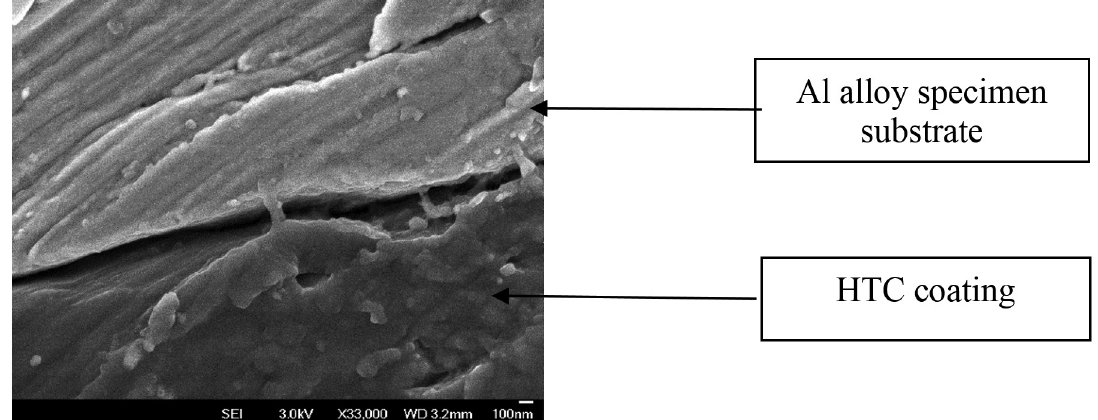
Figure 4. Scanning electron micrograph of cross section of HT-HTC coated specimen showing dense layer close to alloy. Table 3. Effect of duration of HT-HTC formation on E of uncoated and coated AA 6061 in 0.01 M NaCl. Specimen condition Untreated